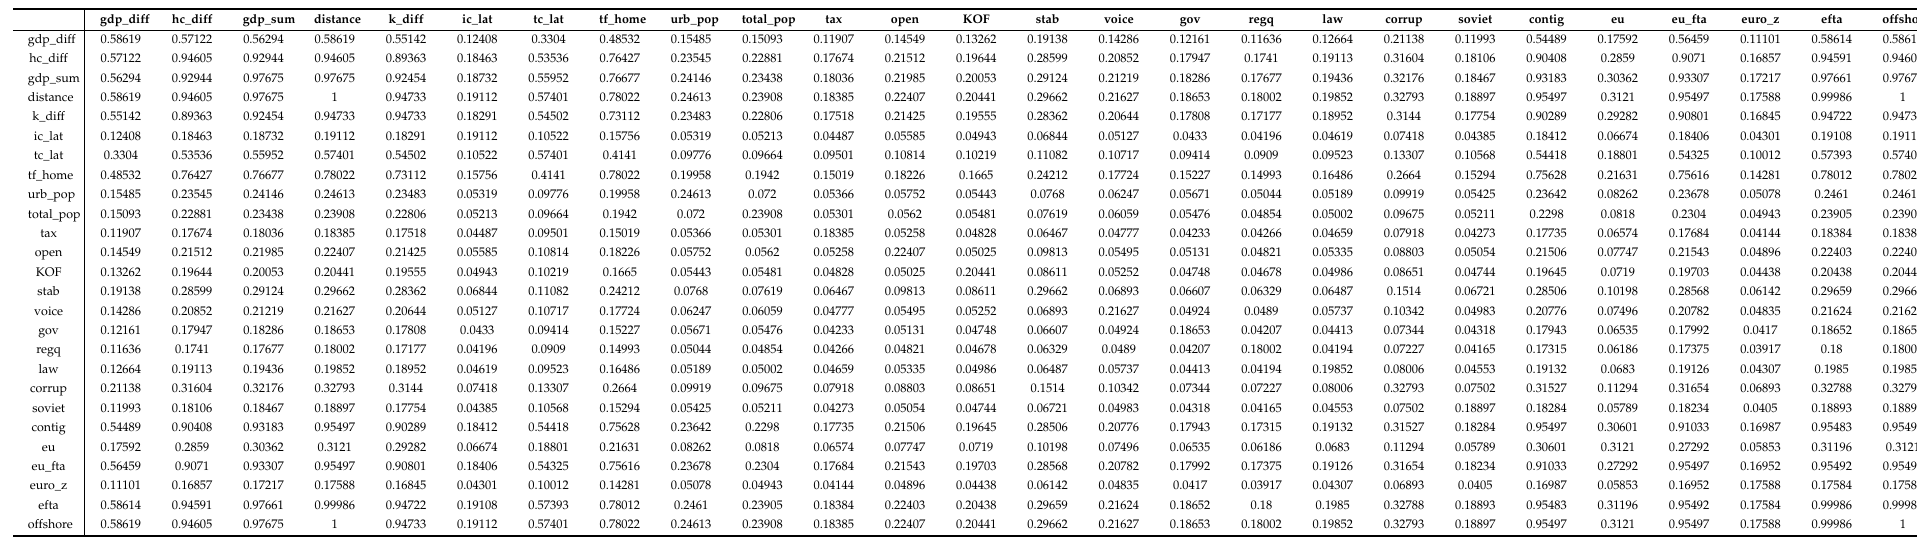
Table A9. Latvia, general case: the joint inclusion probability for all